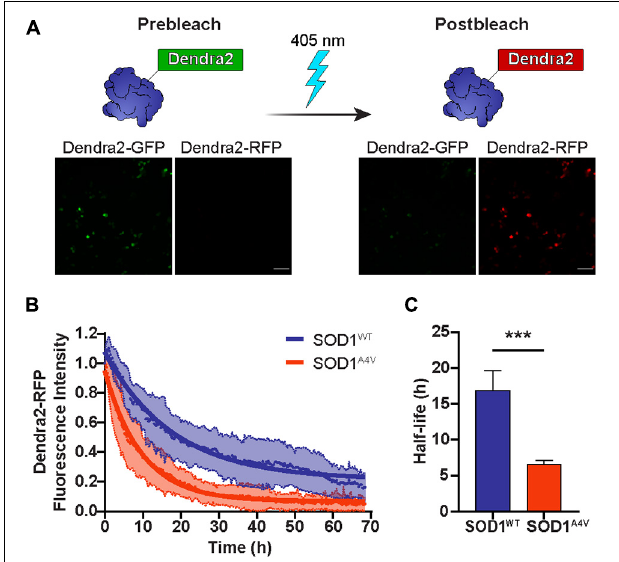
FIGURE 1 | The half-life of SOD1 is diminished by ALS-associated mutations. (A) Dendra2-GFP signal in NSC-34 cells was irreversibly converted to Dendra2-RFP by exposure to 405 nm light. Scale bars: 100 µ m. (B) The degradation of the SOD1-Dendra2-RFP signal in NSC-34 cells was measured over 68 h. Data shown are mean ± SD ( n = 17) with the solid lines representing non-linear regression curves. (C) The half-life of SOD1 WT -Dendra2 and SOD1 A4V -Dendra2 was calculated from the degradation of the SOD1-Dendra2-RFP signal in NSC-34 cells. Data represent mean ± SEM of cells acquired from n = 17 images and statistical significance between groups was determined using an unpaired Student’s t -test (*** p < 0.001). Data is representative of at least two independent